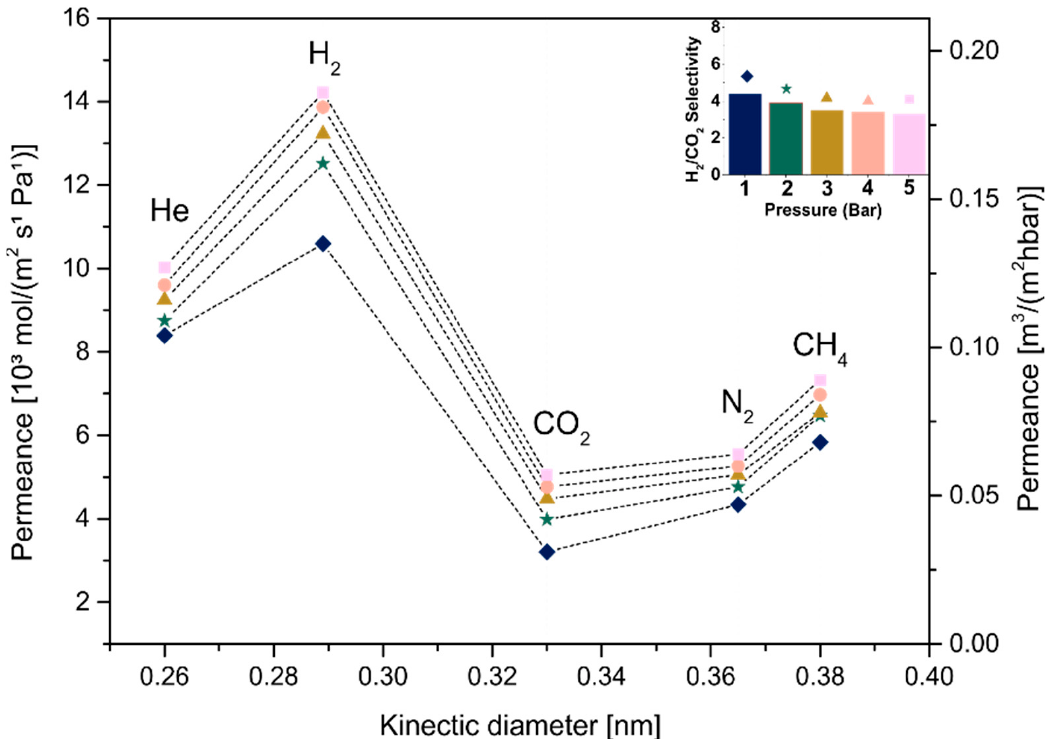
Figure 11. Single-gas permeabilities, permeances and H 2 /CO 2 selectivity under different pressures for C 1 _80.